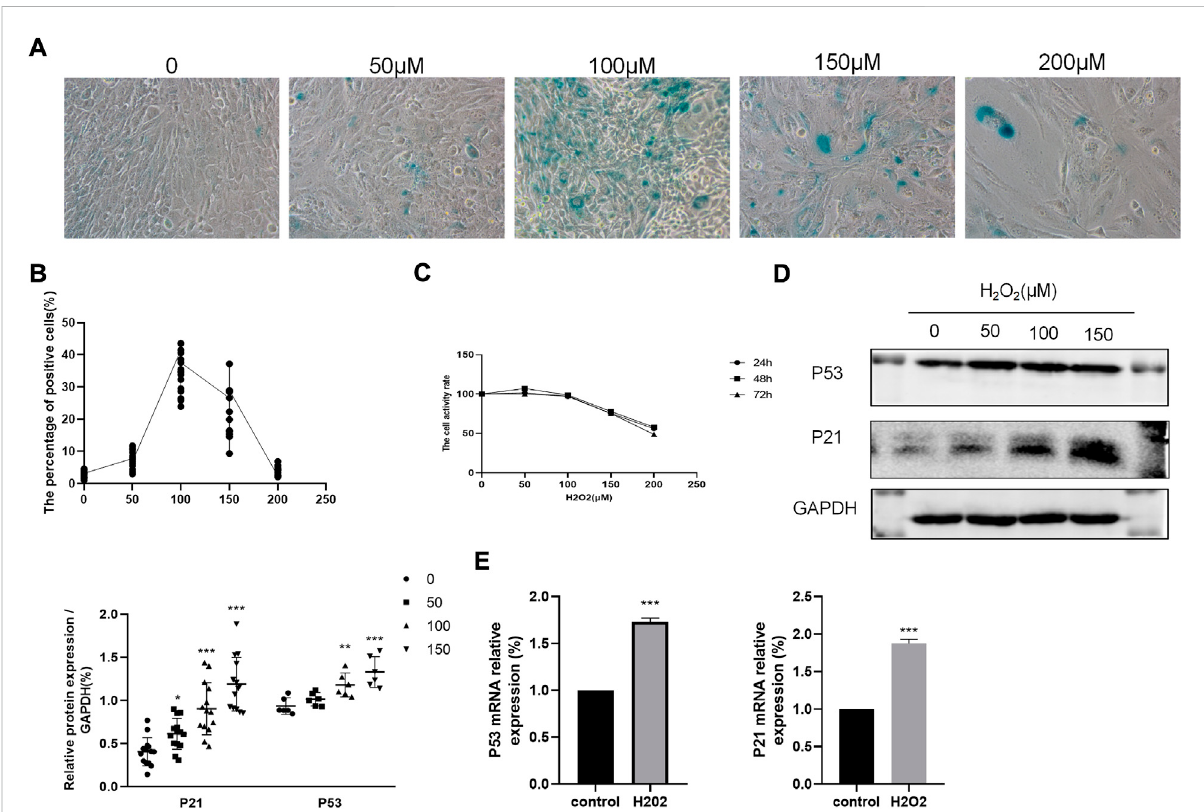
FIGURE 4 Effects of H 2 0 2 in BEAS-2B cells. (A – B) SA- β -gal staining of BEAS-2B cells treated with different concentration of H 2 0 2 . Magni fi cation: ×200. (C) Cell viability assay of BEAS-2B cells treated with different concentration of H 2 0 2 . (D – E) Effects of H 2 0 2 on P53 and P21 protein and mRNA expression. *** p < 0.0001, ** p <